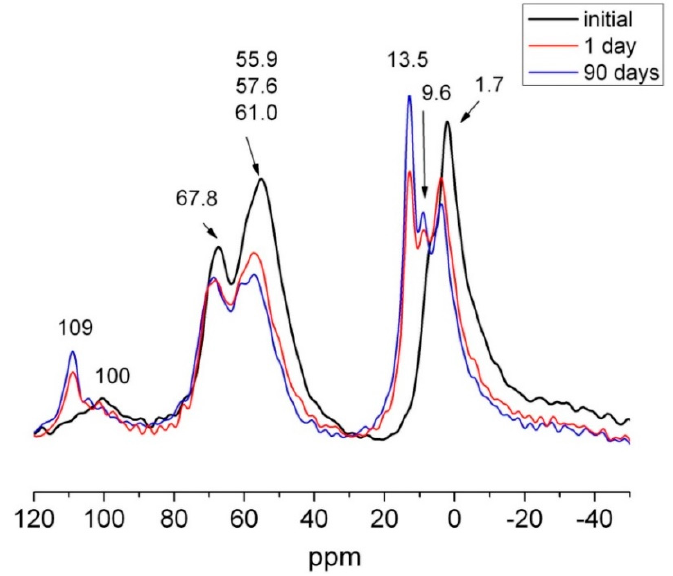
Figure 16. 27 Al NMR spectra for initial, 1 day and 90 days HcG.